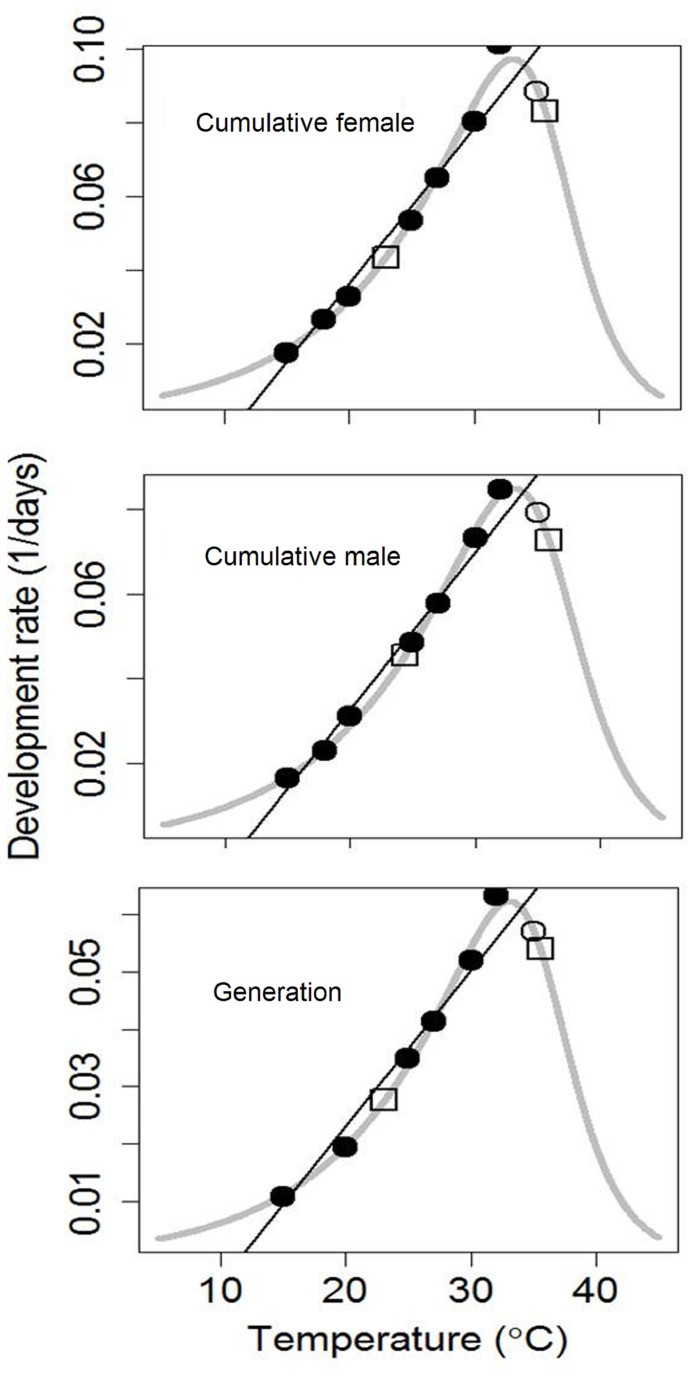
Comparison between the observed and theoretical values of the temperature-dependent development rates of the mealybug

Phenacoccussolenopsis

: the grey curve shows the predicted values by SSI model; the dark solid line shows predictions from the Ikemoto and Takai linear model; the open and closed circles are observed values used in the nonlinear fitting.The closed circles are observed values used in the linear fitting. Open squares from left to right represent the developmental rates at T
ϕ and T
H.